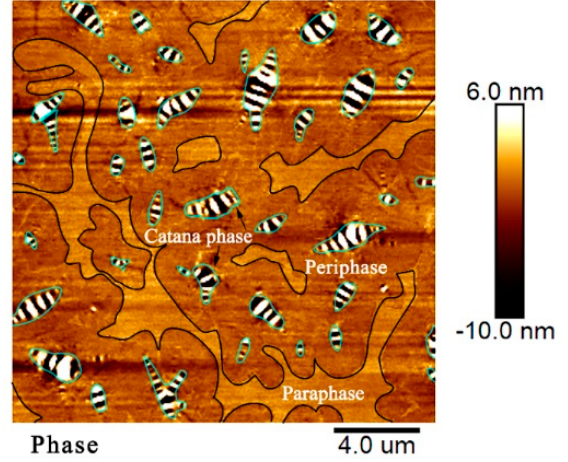
Figure 7. Phase structure of the base asphalt binder.